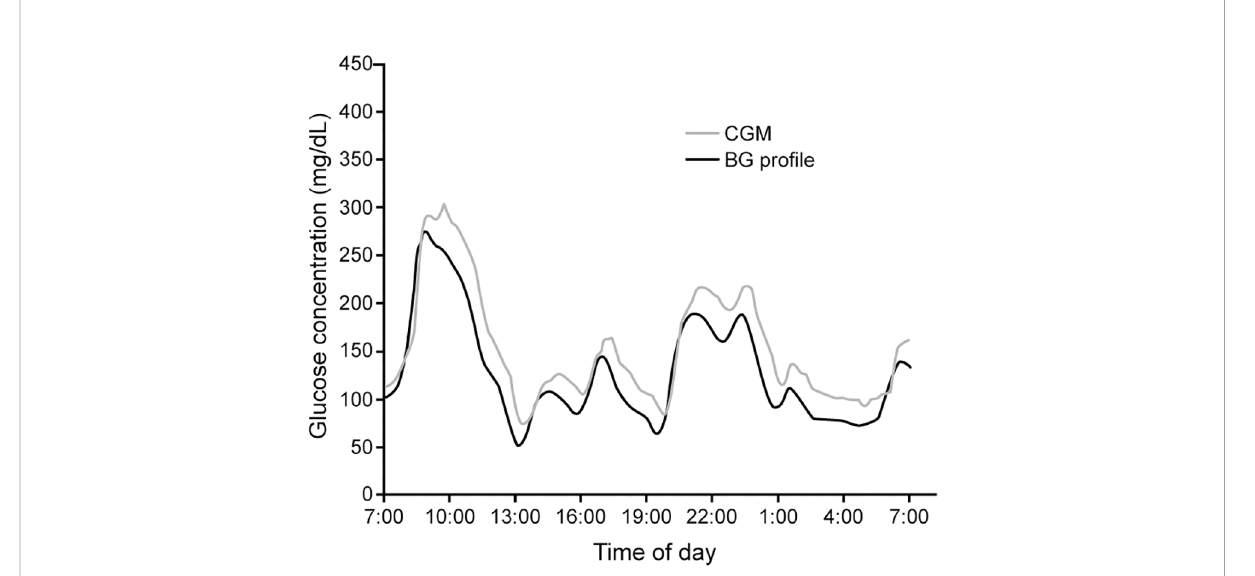
FIGURE 4 Measured CGM data and paired blood glucose measurements (BG pro fi le) in a patient with diabetes (Adapted with permission from Ref